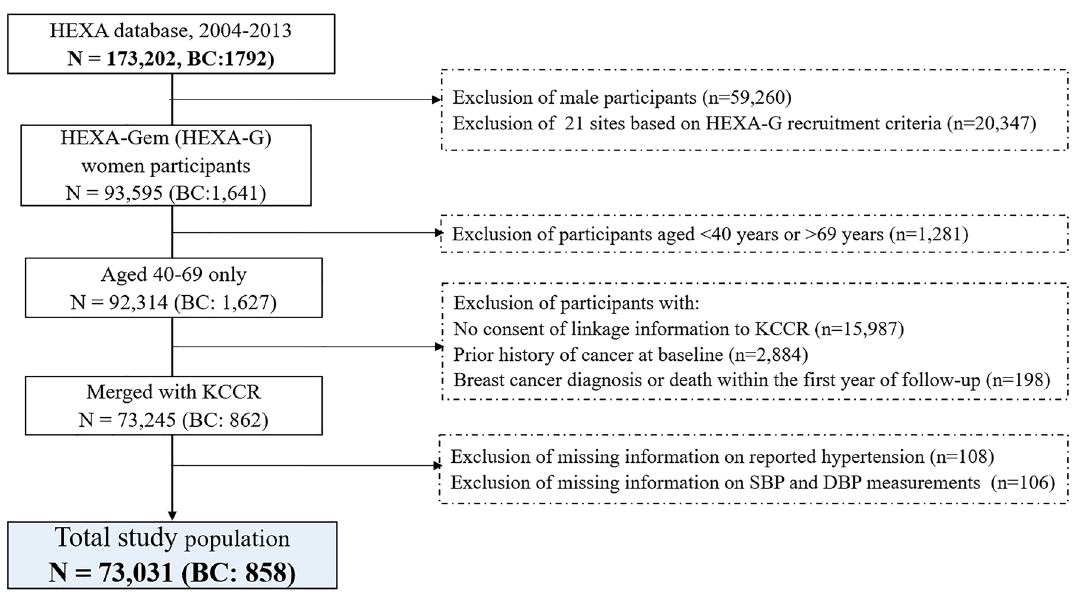
Figure 1. Flow chart of selection of study participants. KCCR Korea Central Cancer Registry, SBP systolic blood pressure, DBP diastolic blood